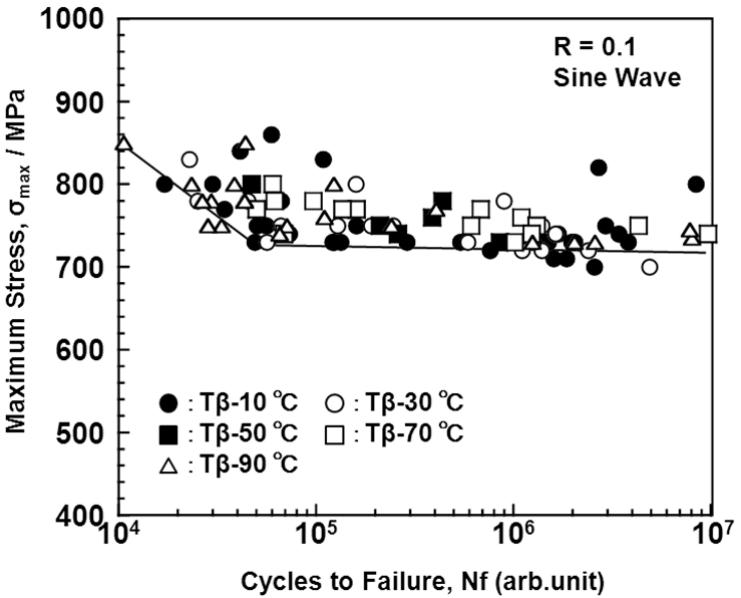
Figure 15. Effect of forging temperature [temperature difference ( Δ T) between T β and heat treatment temperature] on S-N curves obtained by tension-to-tension fatigue test with sine